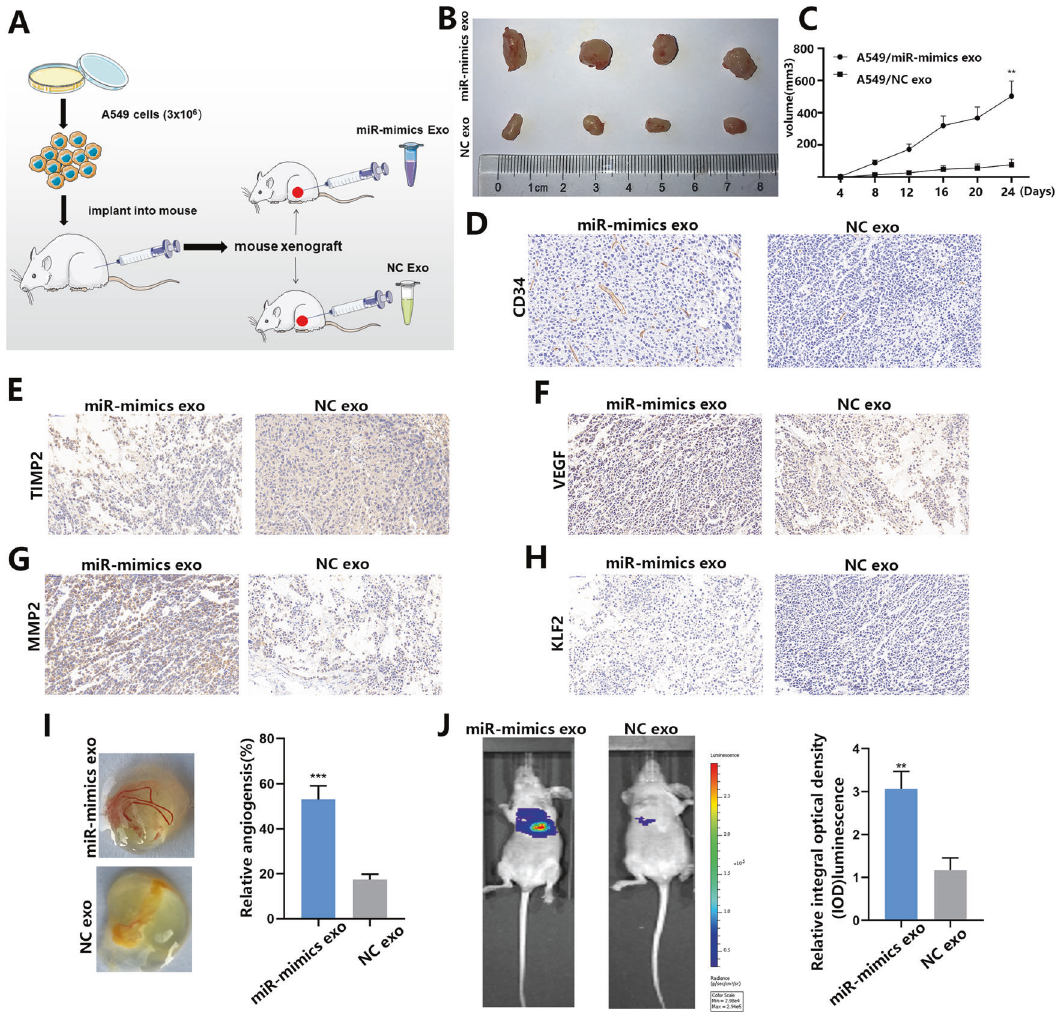
Fig. 7 Exosomal miR-3157-3p promotes angiogenesis and vascular leakiness in vivo. A , B After 7 – 9 days, subcutaneous mouse xenografts were intratumourally injected with miR-3157-3p-mimics Exo or NC-Exo ( n = 4 each). C Tumor volume. D – H CD34, TIMP2, VEGF, MMP2 and KLF2 expression levels the samples collected from nude mice were analyzed by IHC. I the number of branches of blood vessels (5 mm) around the CAM vehicle; J The mice were injected with A549 cells via tail vein after exposure to miR-3157-3p-mimics-Exo or NC-Exo treatments. IVIS Lumina II system was used to detect lung metastatic nodule of nude mice. The data are shown as the mean ± SD ( ** P < 0.01; *** P <